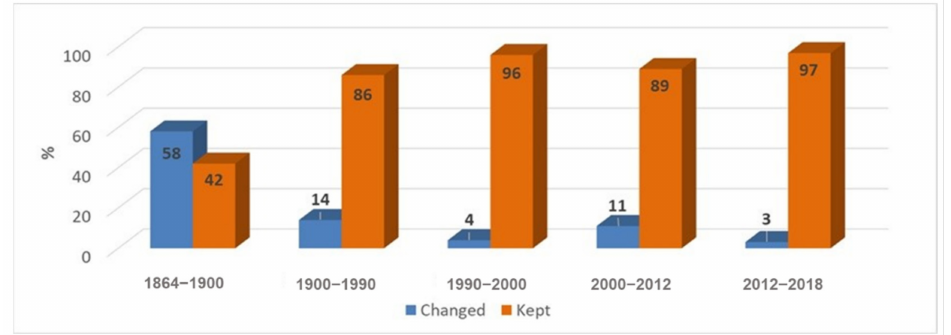
Figure 9. Surfaces of land which has acquired a different usage category (%) between 1864–2018 in Central B ă r ă